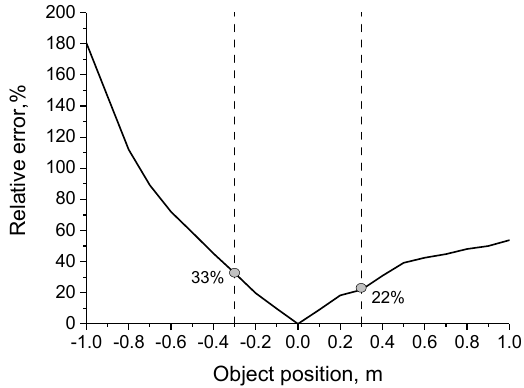
Figure 5. Changes in the relative error of the object area when moving away from and approaching the focal plane. Negative values on the x -axis correspond to moving the object away from the thermal imaging camera; positive values correspond to approaching the thermal imager, respectively.